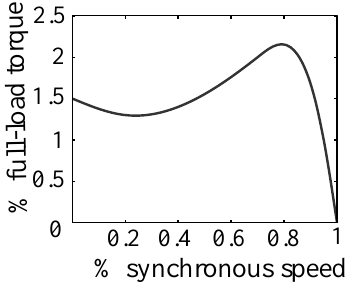
Fig. 8. Speed torque